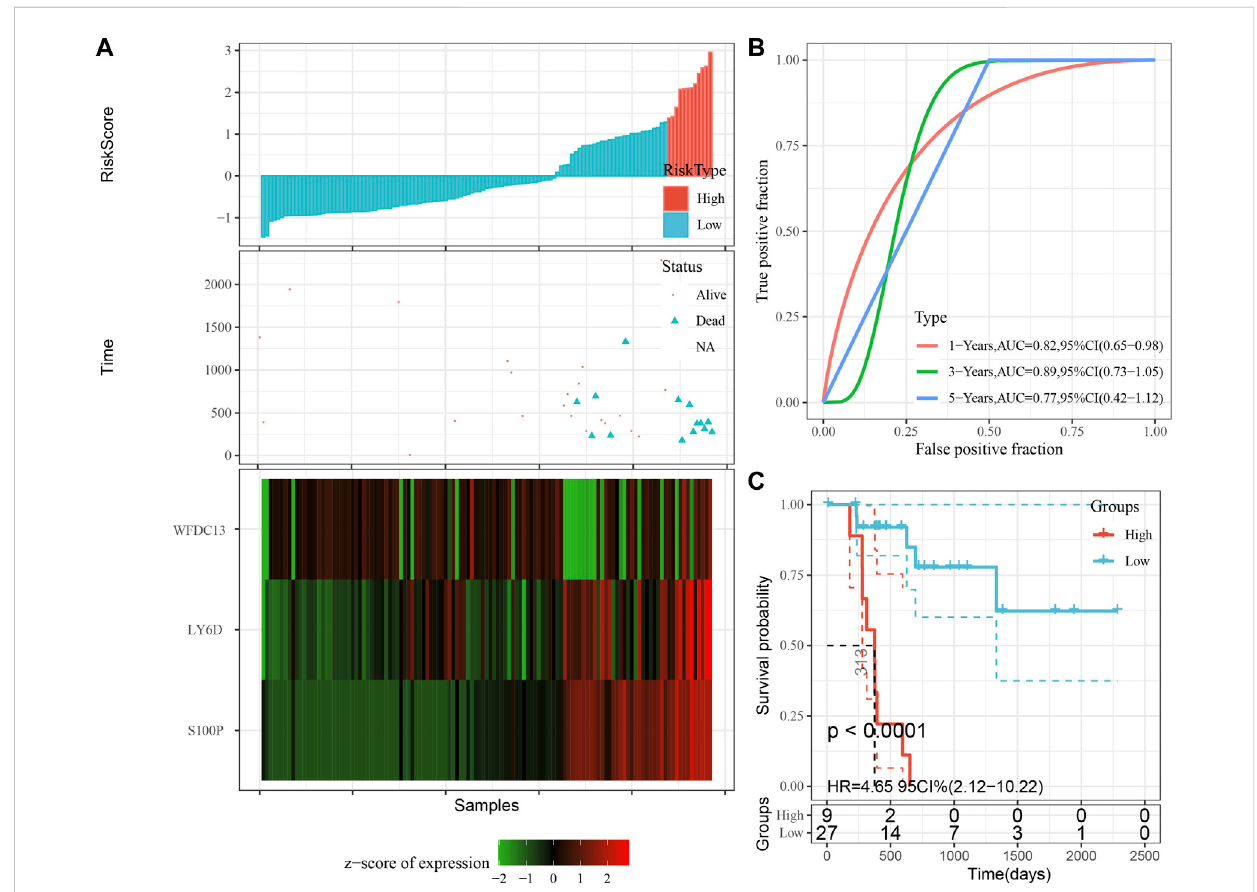
FIGURE 8 Performanceoftheprognosticgenesignatureintrainingset. (A) Riskscore,survivaltimeandsurvivalstatusandexpressionofthe3genesintraining set. (B) ROC curve and AUC of the 3-gene signature classi fi cation. (C) Distribution of KM survival curves of the 3-gene signature in training